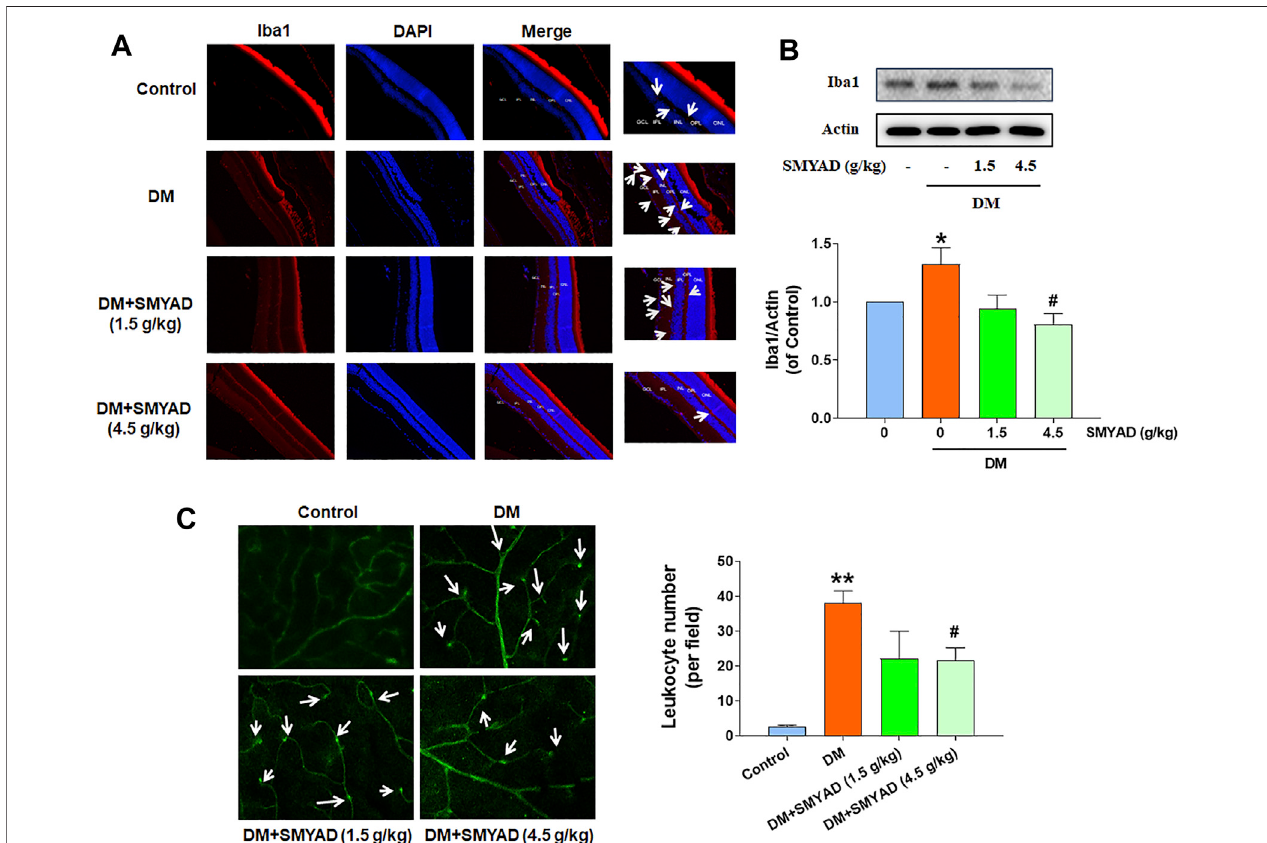
FIGURE 4 | SMYAD alleviated retinal in fl ammation in vivo . (A) Representative images of retinal Iba1 immuno fl uorescence staining (scale bar: 20 mm). Enlarged images are shown at right (scale bar: 5 mm). White arrows indicate microglia. (B) SMYAD reduced the enhanced Iba1 expression in retinas. The quantitative result is shownbelow(n (cid:2) 3). (C) RepresentativeimagesofretinalFITC-ConAstaining.Thenumberofentrappedleukocytesinretinalvesselswascalculatedandisshownatright (n (cid:2) 3). (D) Serum IL-6 amount (n (cid:2) 4). (E) Serum MCP-1 amount (n (cid:2) 3). (F) Retinal mRNA expression of ICAM1 and MCP-1 (n (cid:2) 3). (G) SMYAD decreased the increasedretinal expression ofICAM1 andVCAM1.Thequantitative resultisshownbelow(n (cid:2) 3).Data (cid:2) mean ± SEM.* p < 0.05, ** p < 0.01vs.control; # p < 0.05, ## p < 0.01, ### p < 0.001 vs.